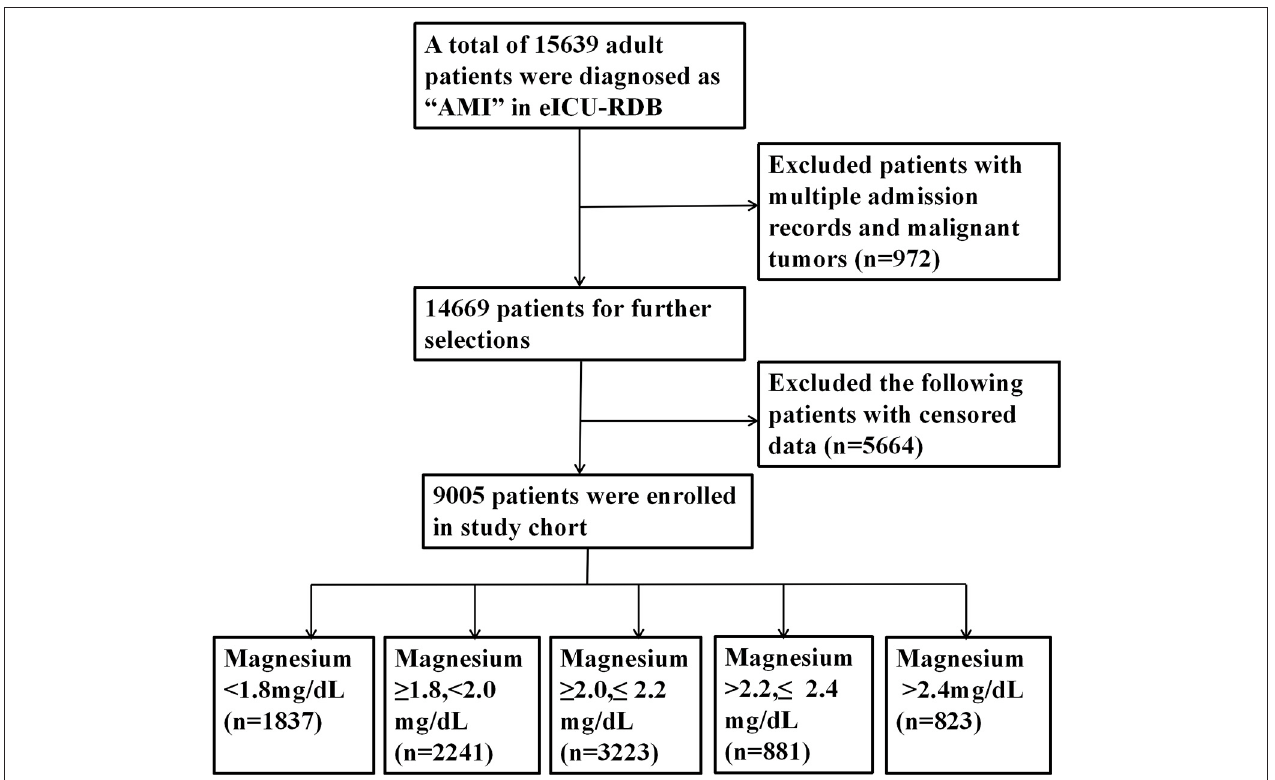
FIGURE 1 | Flowchart outlining patient selection and grouping process.